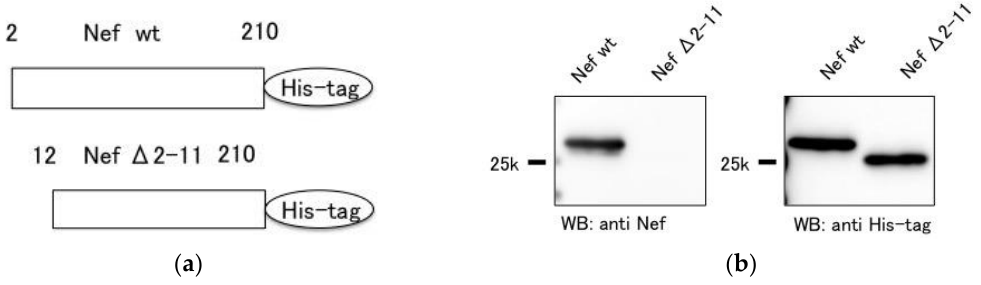
Figure 6. Determination of the epitope of the anti-Nef antibody. ( a ) Schematic illustration of Nef wt and Nef ∆ 2-11. ( b ) Western blotting with the anti-Nef antibody (left) and anti-His-tag antibody (right).